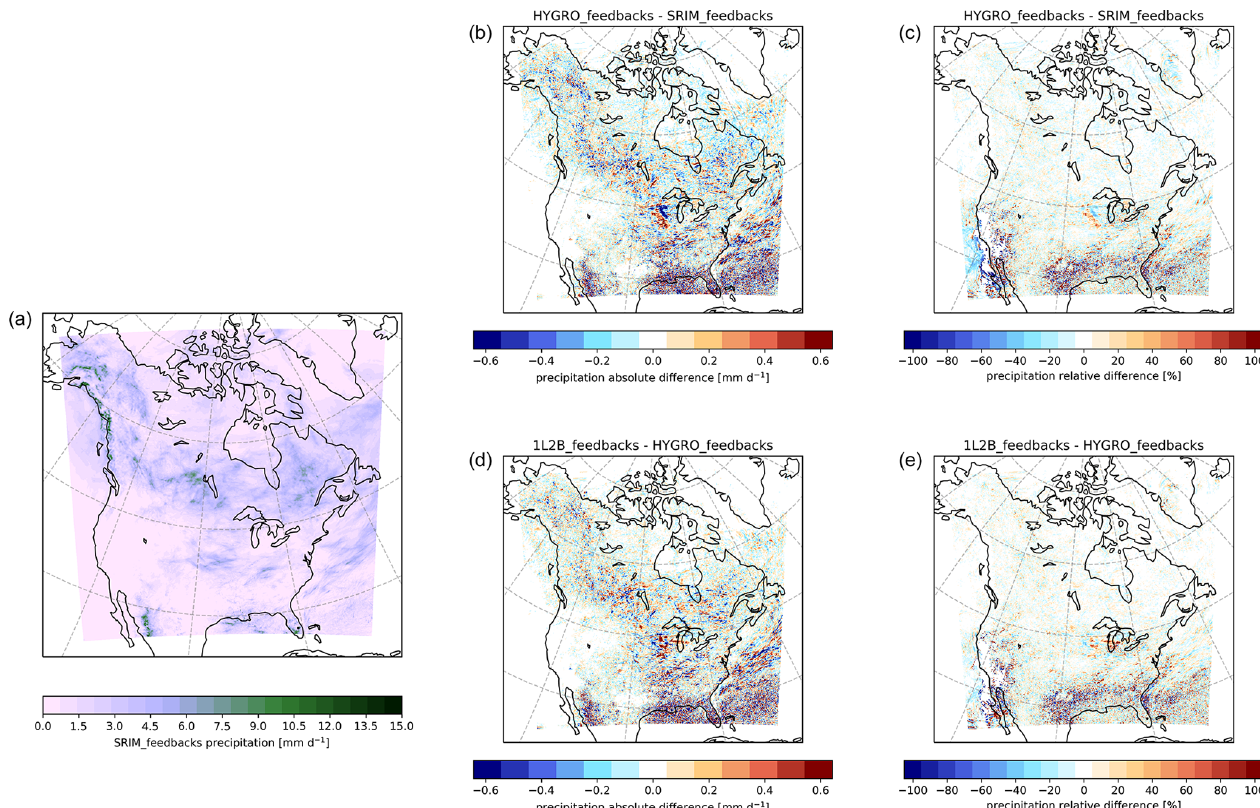
Figure 10. (a) Mean precipitation from the SRIM_feedback simulation, (b) mean difference in precipitation between the HYGRO_feedback and SRIM_feedback simulations, (c) relative difference in mean precipitation between the HYGRO_feedback and SRIM_feedback simu- lations, (d) mean difference in precipitation between the 1L2B_feedback and HYGRO_feedback simulations, and (e) relative difference in mean precipitation between the 1L2B_feedback and HYGRO_feedback